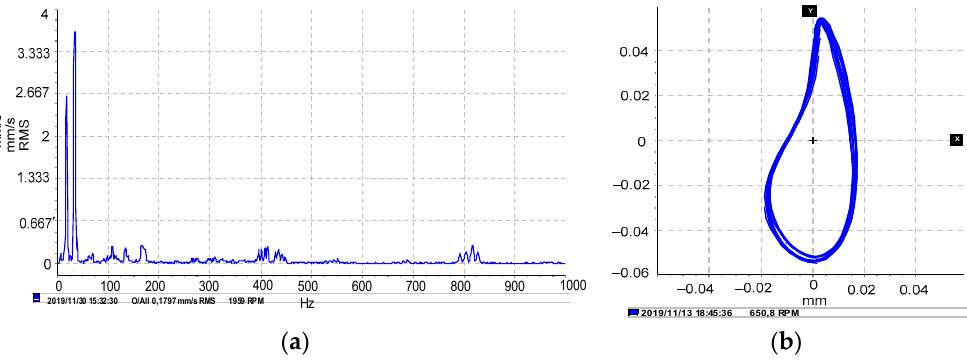
Figure 7. Rotor unbalance in an inviscid fl uid: ( a ) Frequency response; ( b ) rotor orbit.